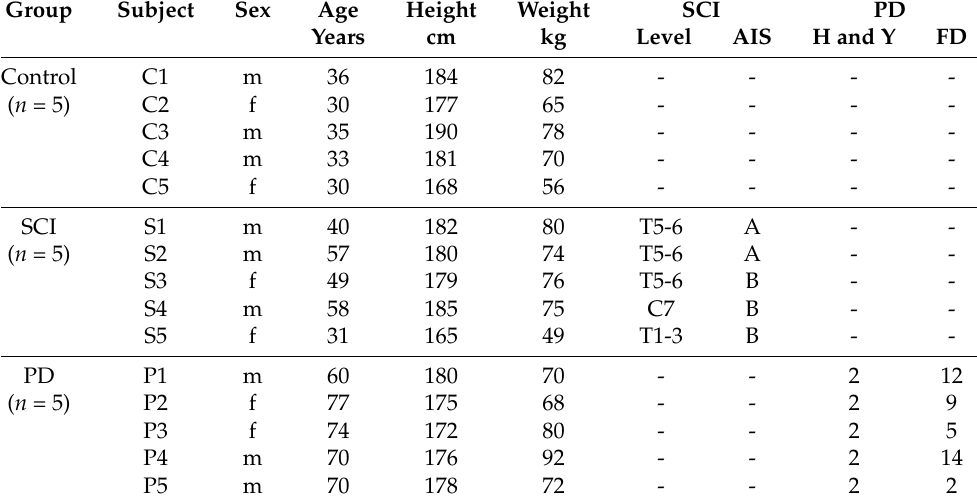
Table 1. Clinical characteristics of study